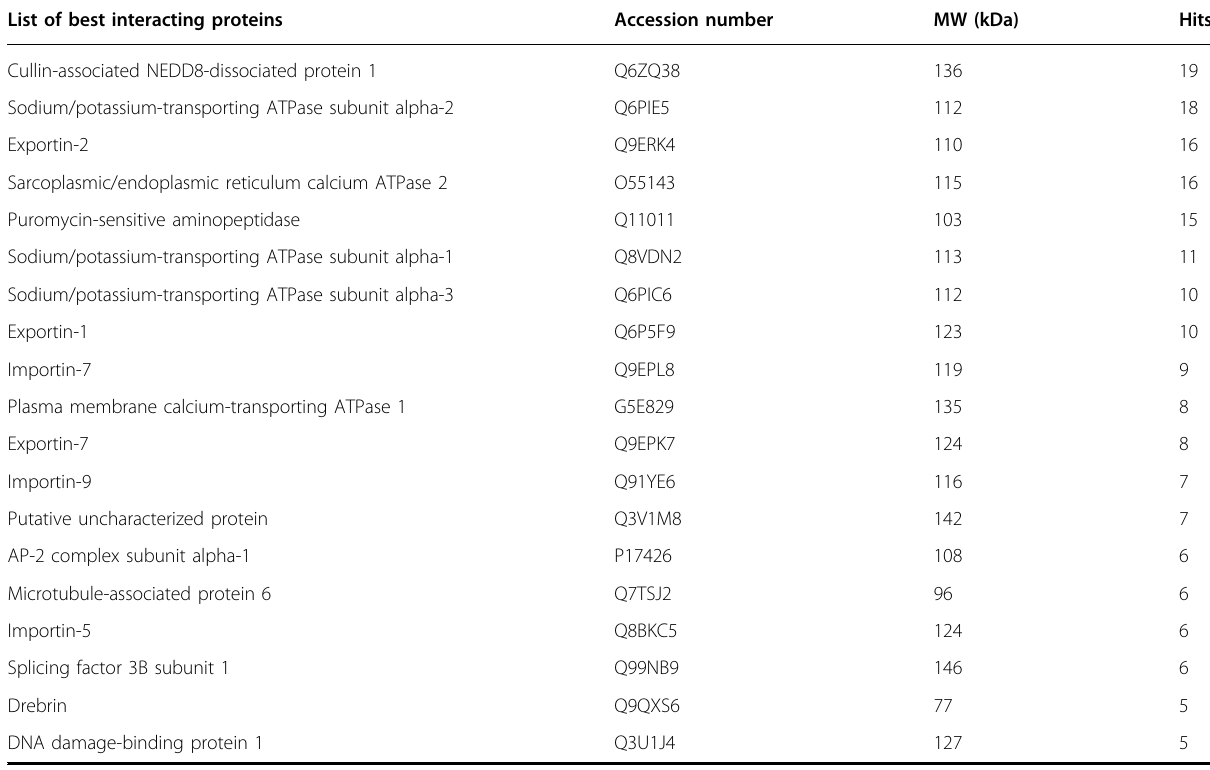
Table 1 List of best interacting proteins obtained by mass spectrometry analysis. List of best interacting